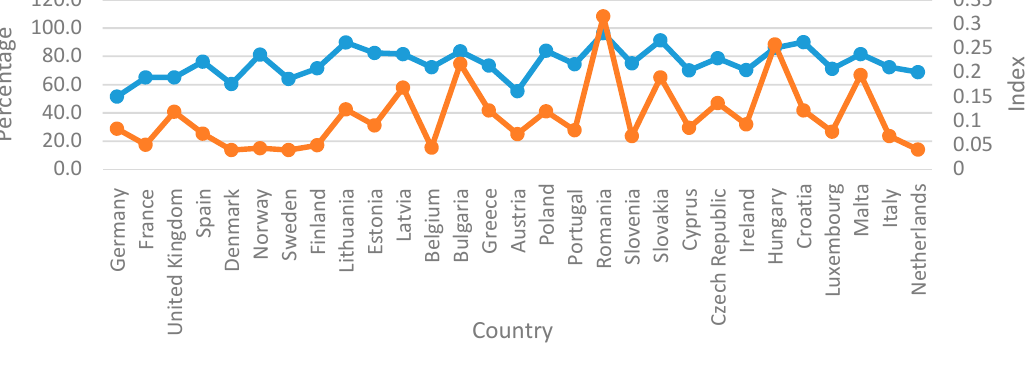
Figure 7. Correlation between the population distribution by the income group, type of household and tenure status, and the gender inequality index of the 25 EU countries, the UK and Norway under evaluation (data for 2018).